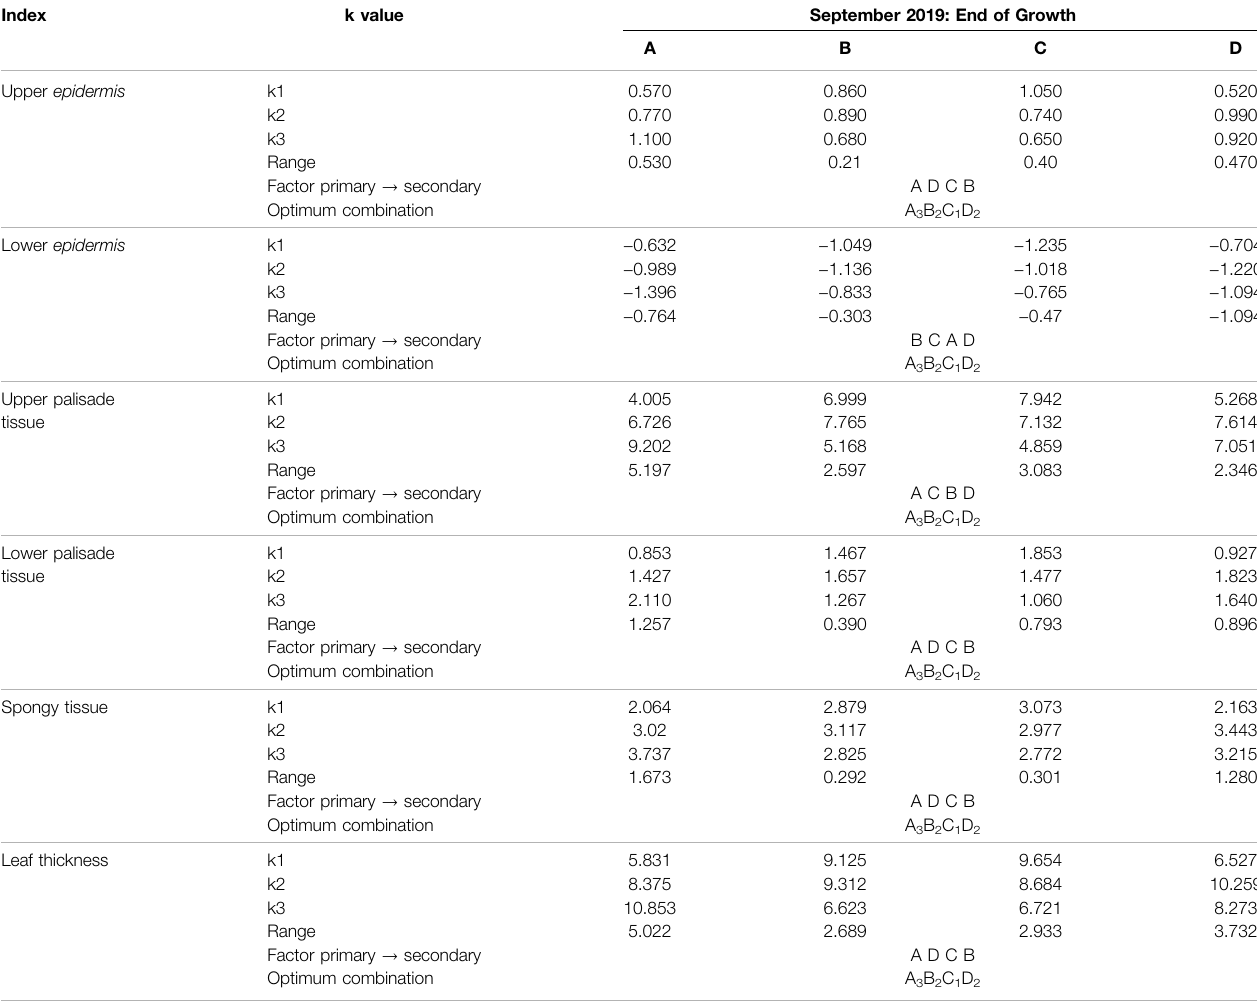
TABLE 5 | Orthogonal test analysis of arti fi cially regulated growth of leaf conformation indicators of Elaeagnus angustifolia